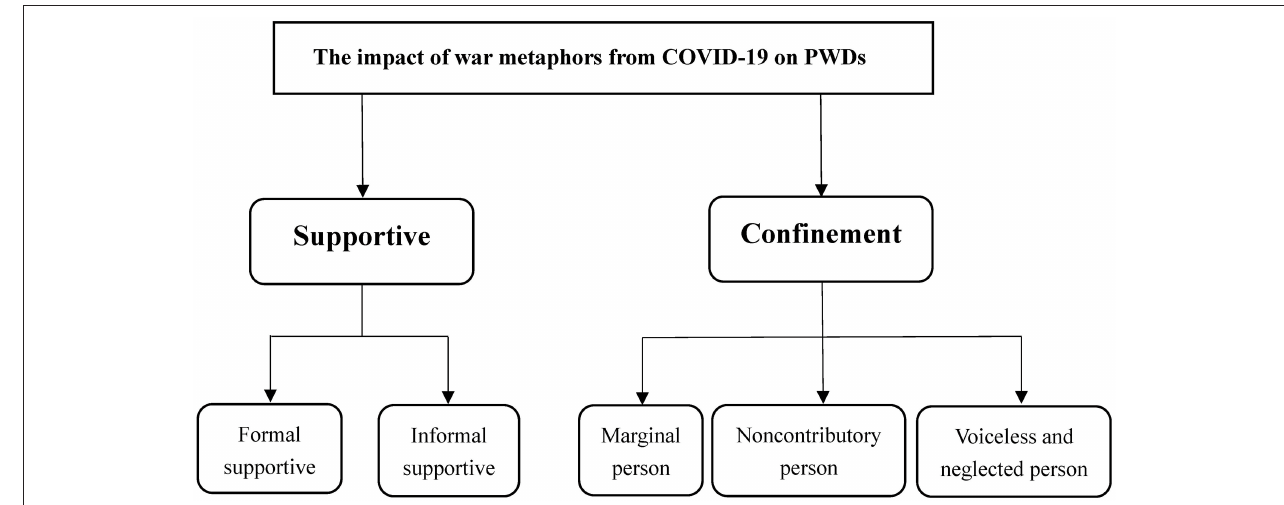
FIGURE 2 | The logical framework of this